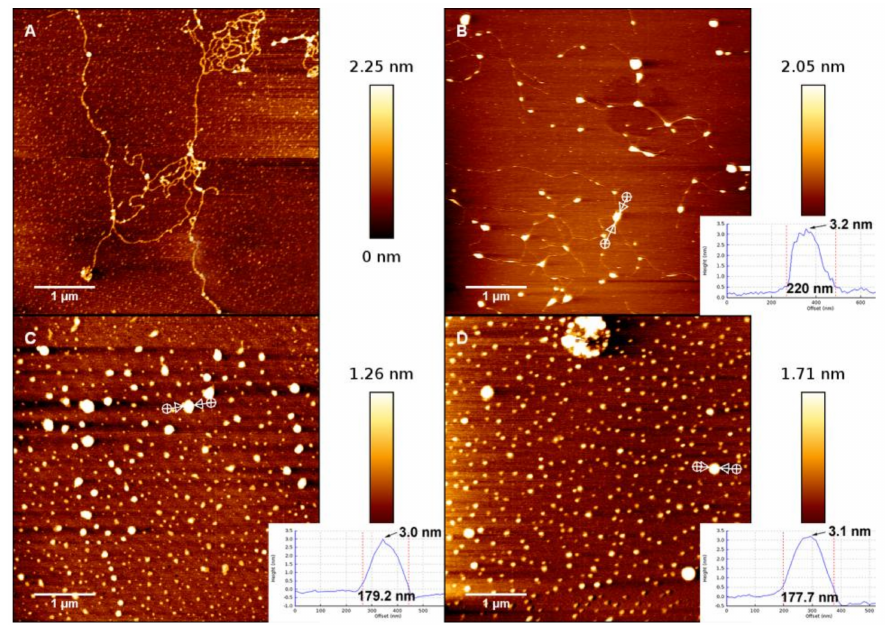
Figure 7. AFM observation of DNA complexes. Panel ( A ): λ -DNA in 0.0007 mM Fe 3+ solution. Panel ( B – D ): DNA conformations at different concentrations (0.0009, 0.003, and 0.03 mM) of Fe 3+ solution.